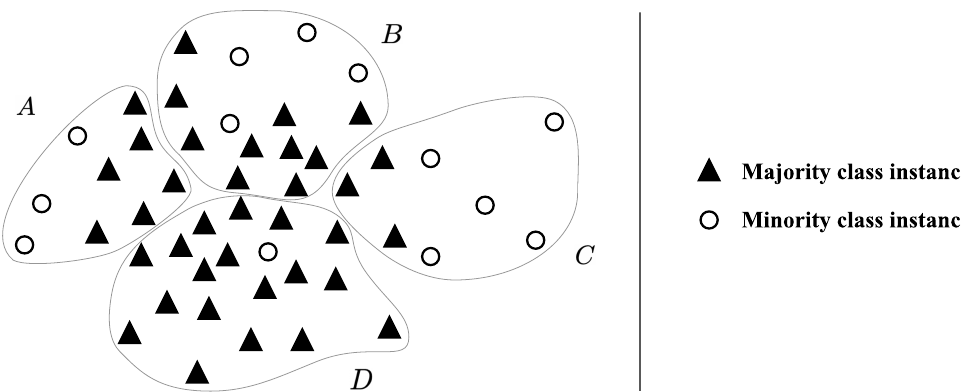
Figure 1. Example of a complex input space. In this example, a classifier would need to separate the minority class’ samples across 4 distinguishable clusters ( A , B , C and D